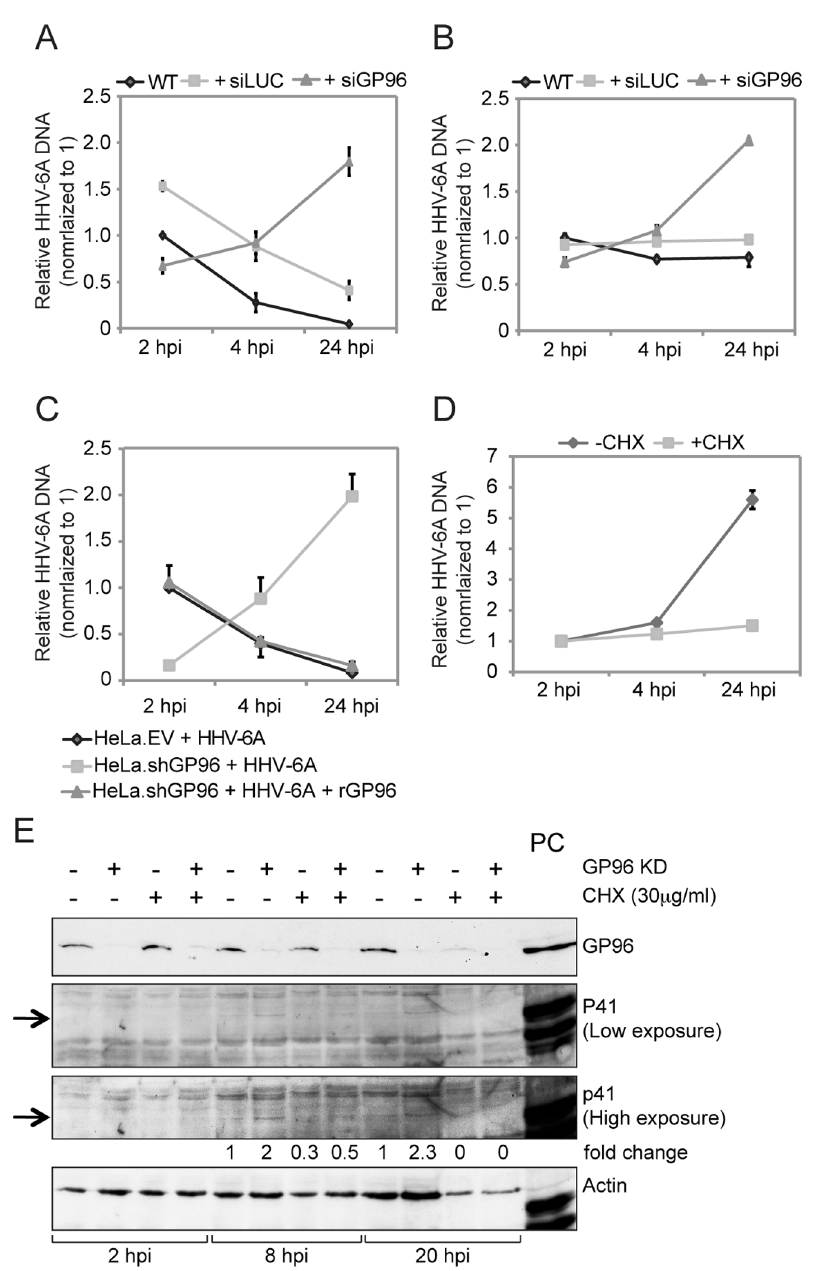
Figure 3. Absence of GP96 induces viral replication. ( A ) Decrease in cell surface GP96 expression decreases HHV-6 entry but increases subsequent replication of viral DNA. HeLa cells were transfected with siRNA against human GP96. In parallel, cells were transfected with siRNA against the luciferase gene (siLUC) as a control. Blank transfected as well as siGP96 and siLUC transfected cells were washed thoroughly and infected with HHV-6A for 2 hrs. After 2 hrs of viral infection, cells were washed with trypsin and extensive washing with PBS to remove any bound but non-entered HHV-6 particles. Cells were then incubated for different time intervals in the absence of viral particle in the culture media and subsequently processed for quantification of viral DNA amount by qPCR. ( B ) The experiment described under (A) was performed in HSB-2 cells. ( C ) HHV-6A entry decreases in absence of GP96. HeLa cells carrying lentivirus- mediated stable knock down of GP96 (HeLa.shGP96) and vector control (HeLa.EV) were infected with HHV- 6A. In parallel, HeLa.shGP96 cells were transiently transfected with a construct expressing human GP96 (rGP96) for 24 h and were also infected with HHV-6A. Cells were processed as mentioned above and